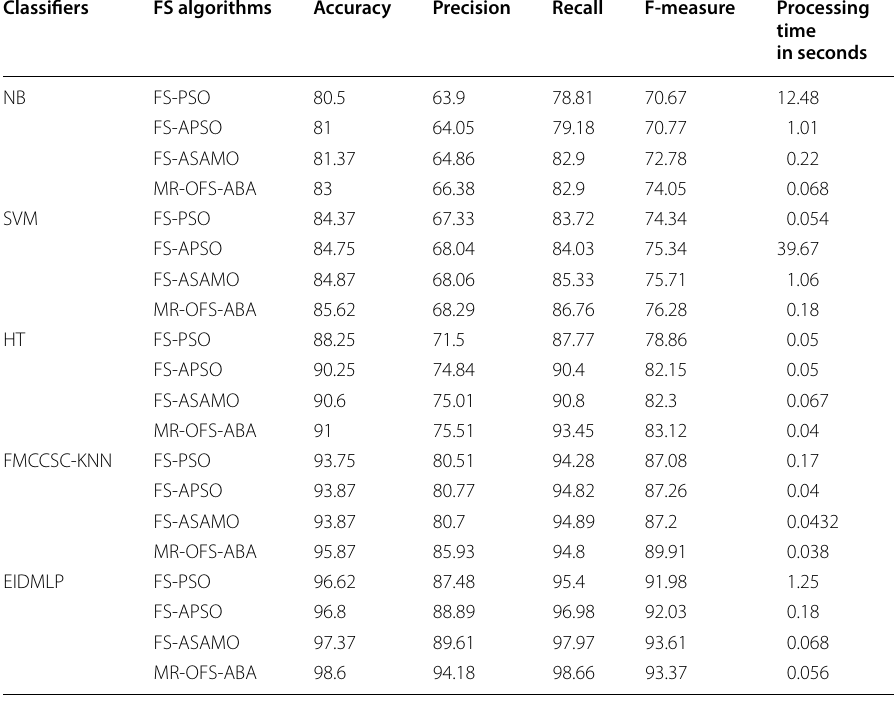
Table 1 Classification results of Dorothea Classifiers FS